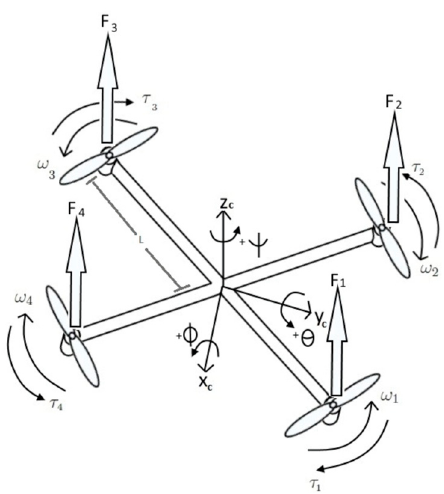
Figure A1. Quadrotor coordinate systems.